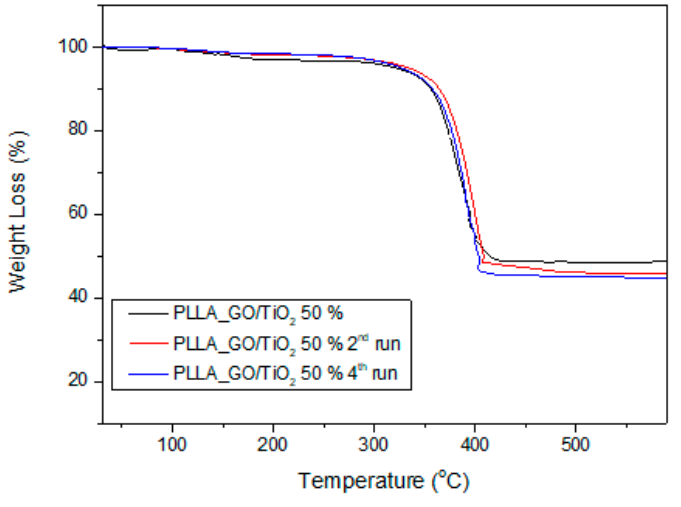
Figure 9. Mass loss of PLLA-GO / TiO 2 50 wt% before photocatalysis, after the second run and after the fourth photocatalytic run.